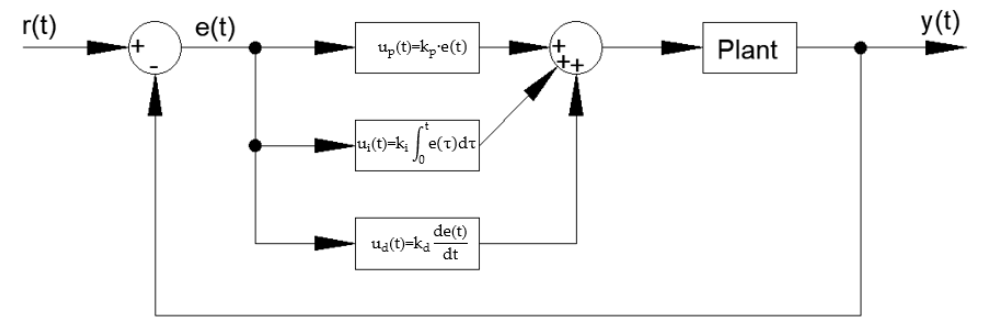
Figure 18. PID Controller internal block structure [24].